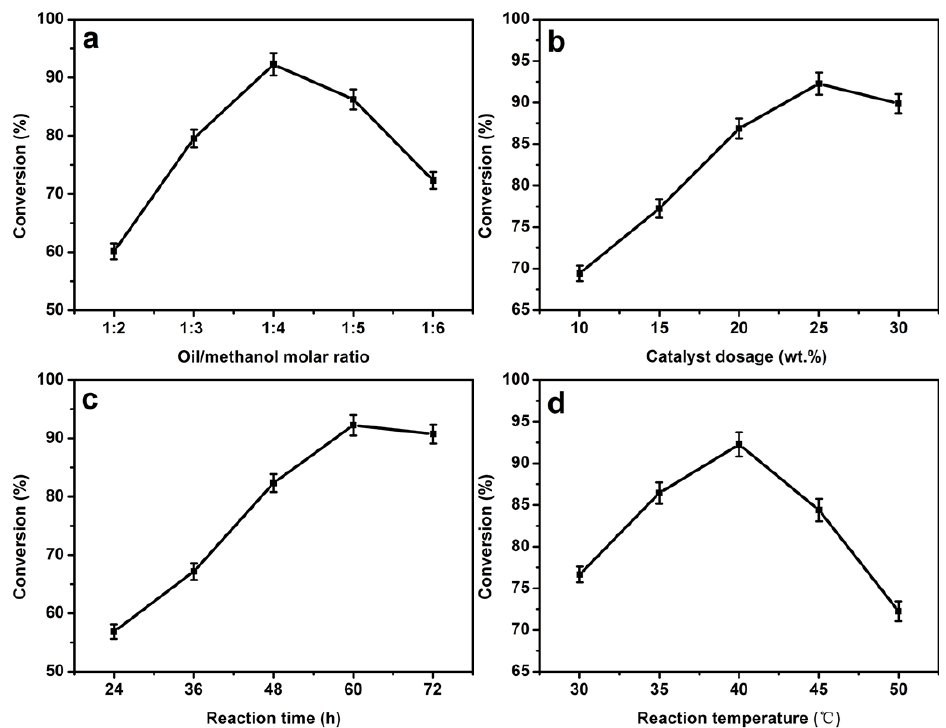
Figure 11. Influence of oil/methanol molar ratio ( a ), catalyst dosage ( b ), reaction time ( c ), and reaction temperature ( d ) on the oil conversion over the immobilized lipase. Other transesterification conditions are as follows: Biocatalyst amount, 25 wt.%; methanol/oil molar ratio, 4:1; reaction temperature, 40 °C; reaction time, 60 h.